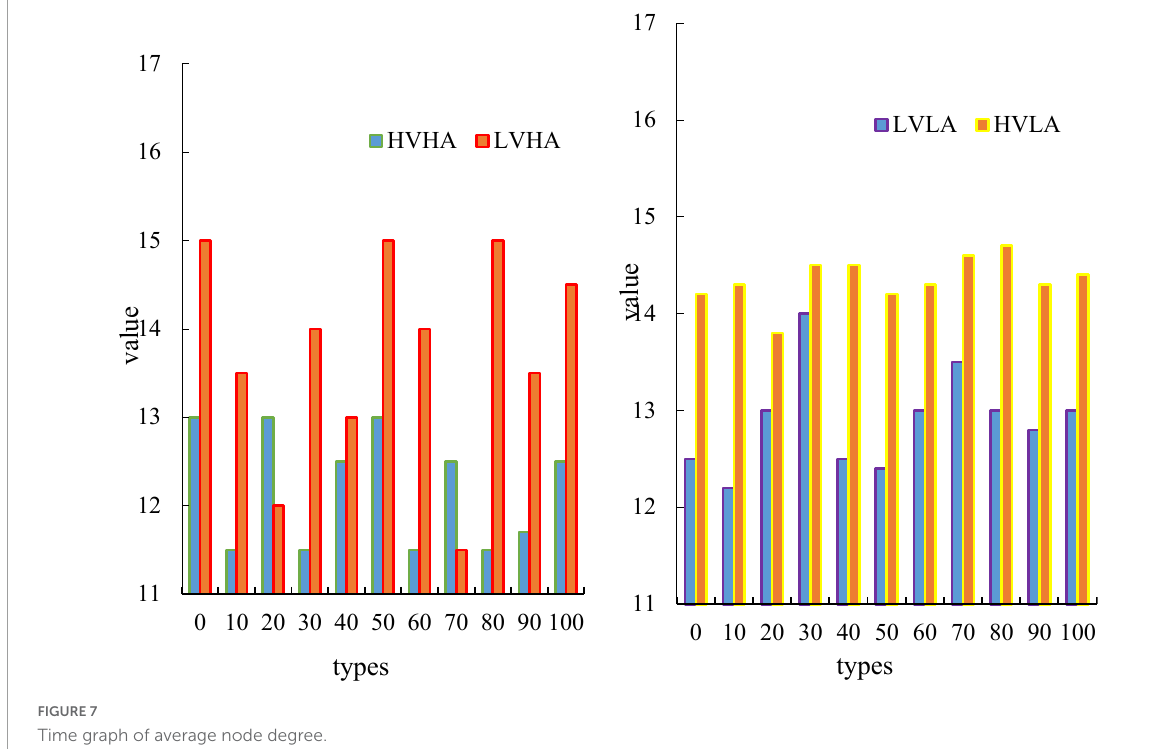
FIGURE7 Time graph of average node degree.